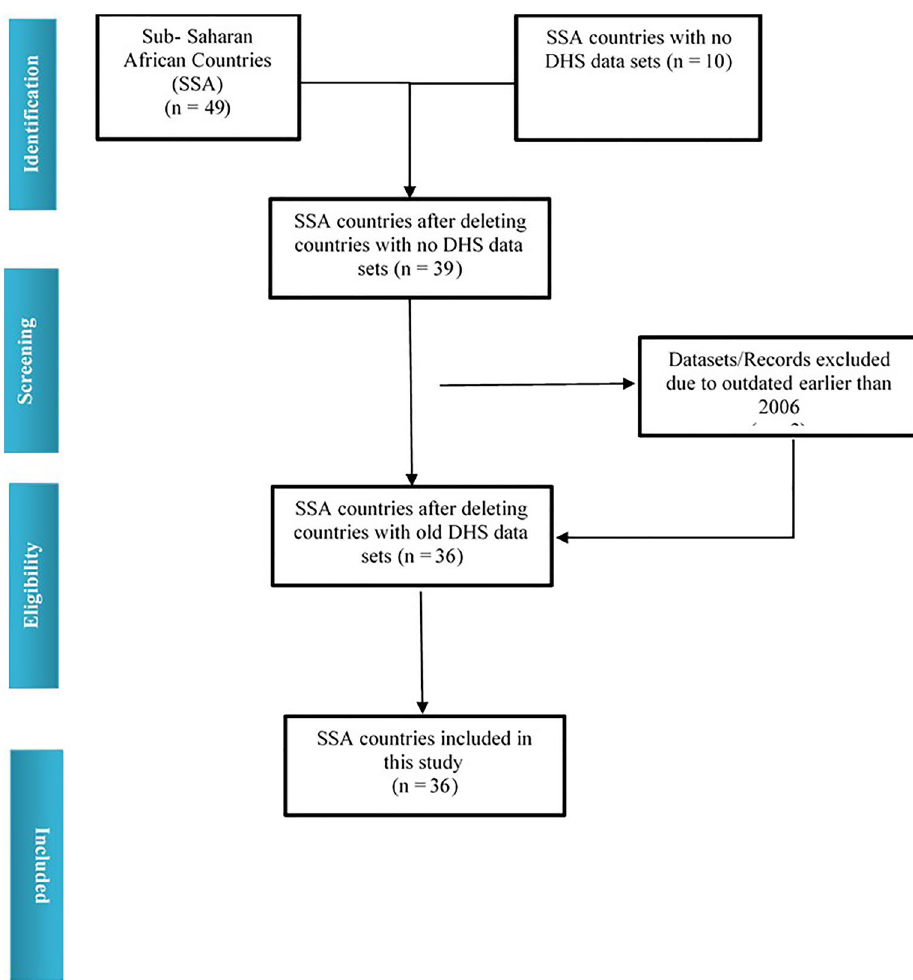
Figure 1. PRISMA (preferred reporting items for systematic reviews and meta-analysis) flow diagram illustrating the process of identifying and including DHS datasets for the random effect